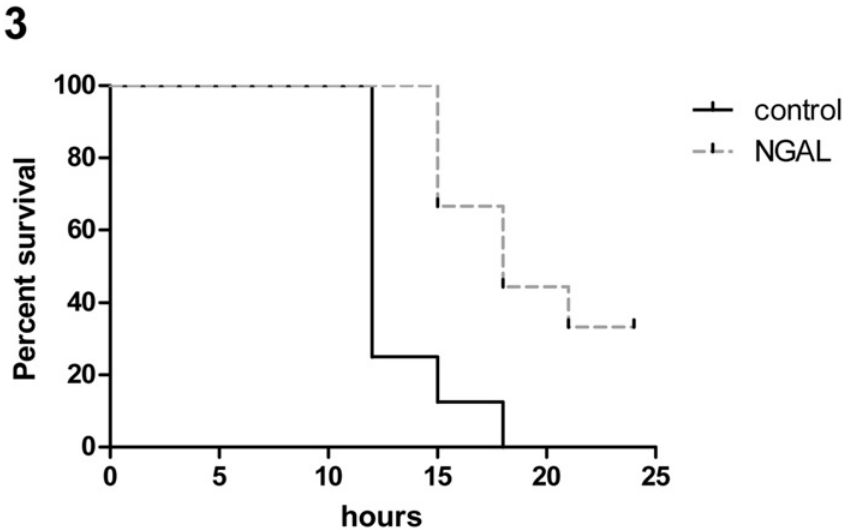
Fig 3. Kaplan Meier survival analyses of mice with sepsis. Kaplan Meier survival analyses of mice with sepsis. Sepsis was induced by peritoneal contamination and infection and subcutaneous treatment with recombinant mouse Lipocalin-2 (n = 9, dotted line in grey) or placebo (n = 8, line in black) was performed. Log-rank test P < 0.01.